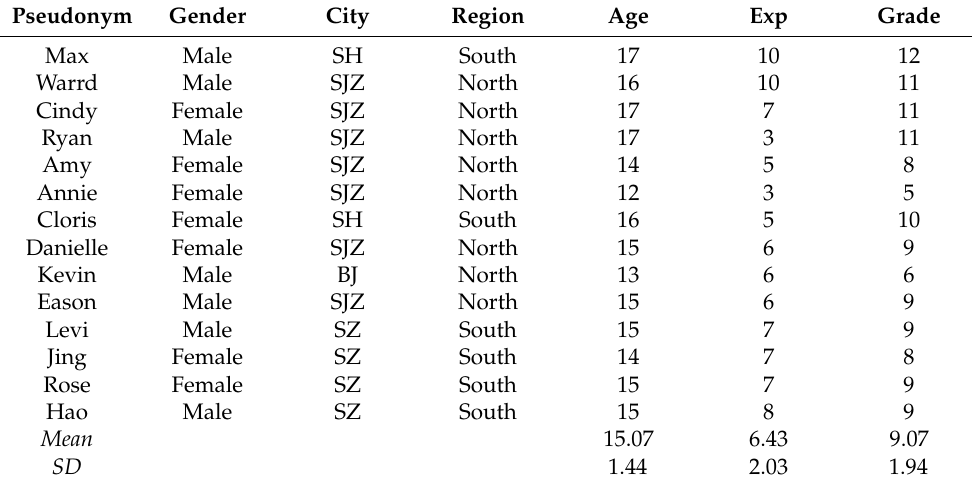
Table 1. Characteristics of participants ( n = 14).